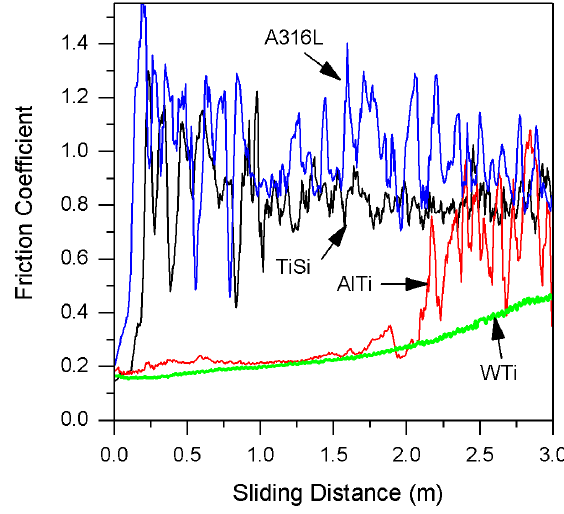
Figure 4. Coefficient of friction of the TiSi, AlTi, and WTi coatings and the 316L stainless steel substrate.